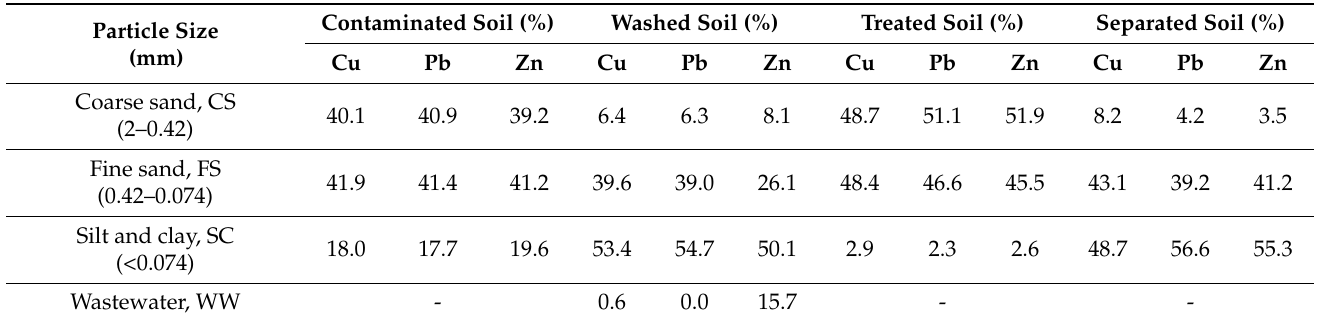
Table 4. Heavy metal mass loadings change thorough high-pressure washing process for contami- nated soil, washed soil, treated soil, and separated